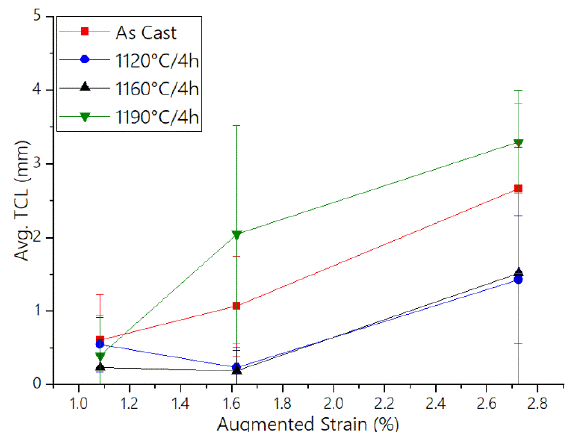
Figure 7. Average total crack length (TCL) in heat-affected zone (HAZ).